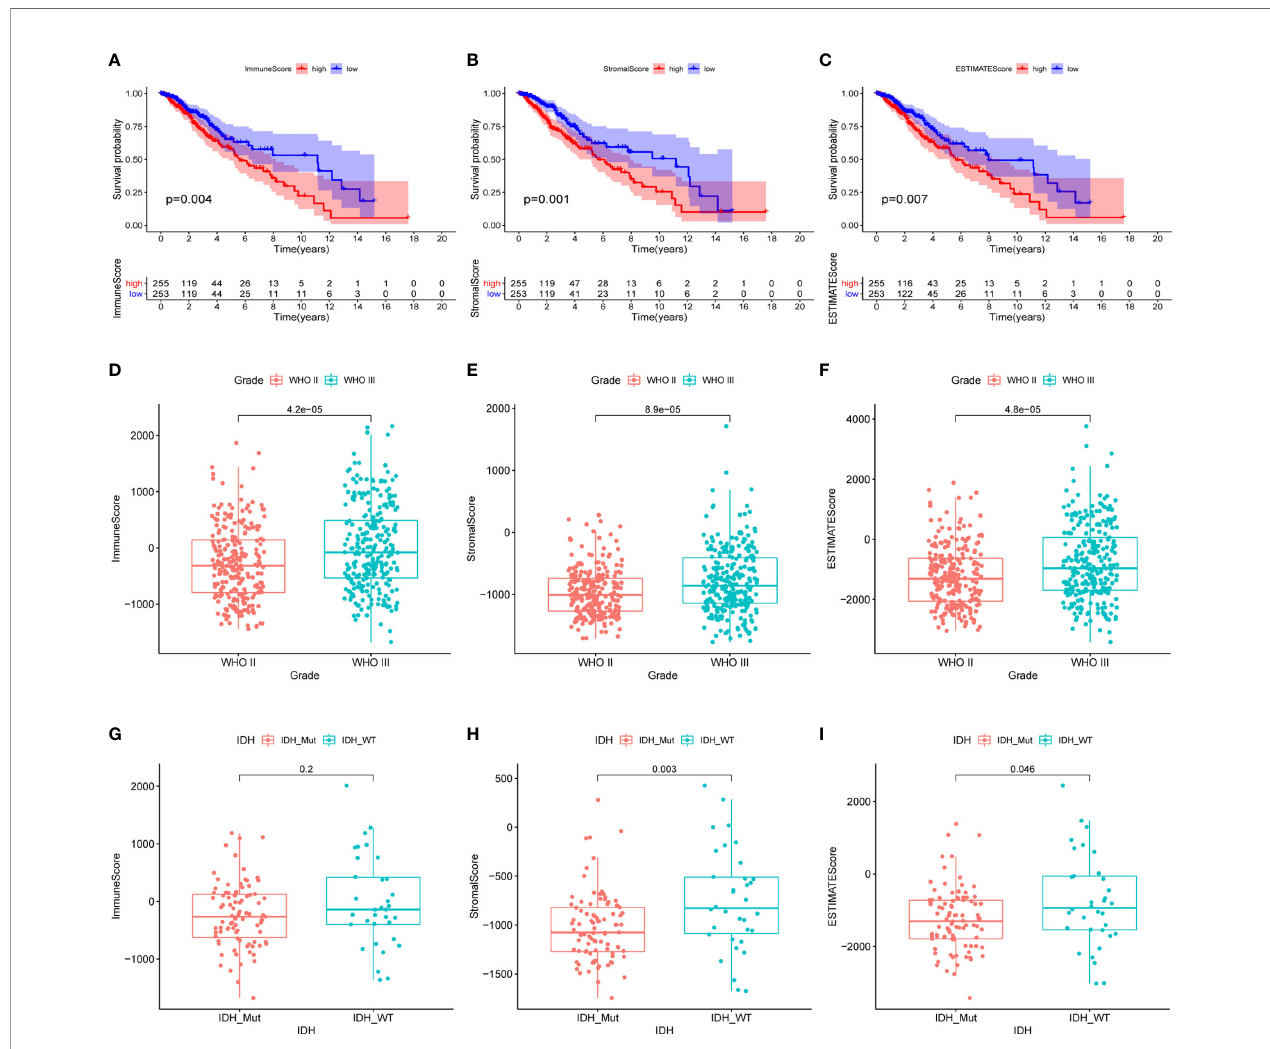
FIGURE 1 | Relationship between the immune, stromal, ESTIMATE scores and the clinical characteristics of the LGG patients. (A) Kaplan-Meier survival analysis of LGG patients in high and low immune-score groups. (B) Kaplan-Meier survival analysis of LGG patients in high and low stromal-score groups. (C) Kaplan-Meier survival analysis of LGG patients in high and low ESTIMATE-score groups. (D – F) The distribution of immune score, stromal score, ESTIMATE score in tumor grades. (G – I) The distribution of immune score, stromal score, ESTIMATE score in IDH status. P-value < 0.05 was considered statistically signi fi